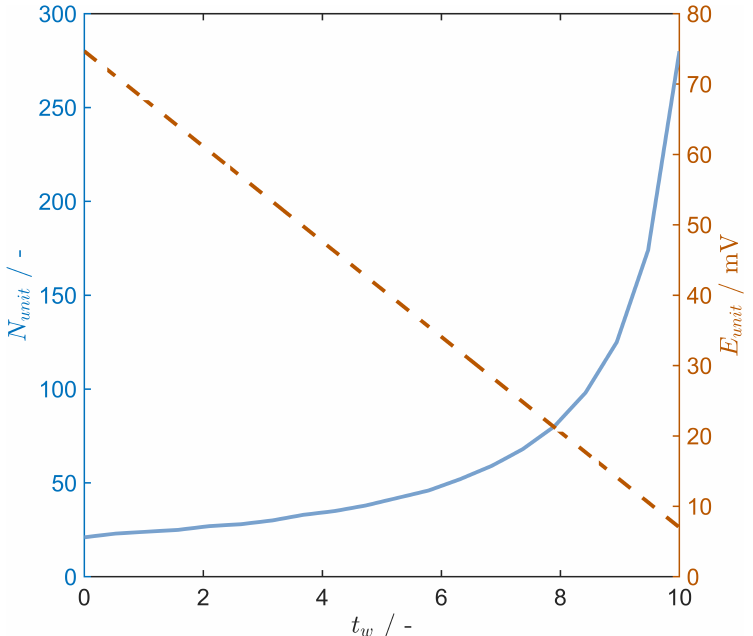
Figure 8. Number of unit cells required for electrolysis (solid line, blue) and unit cell potential (dashed line, orange) as a function of the water transference number for the evaporation case